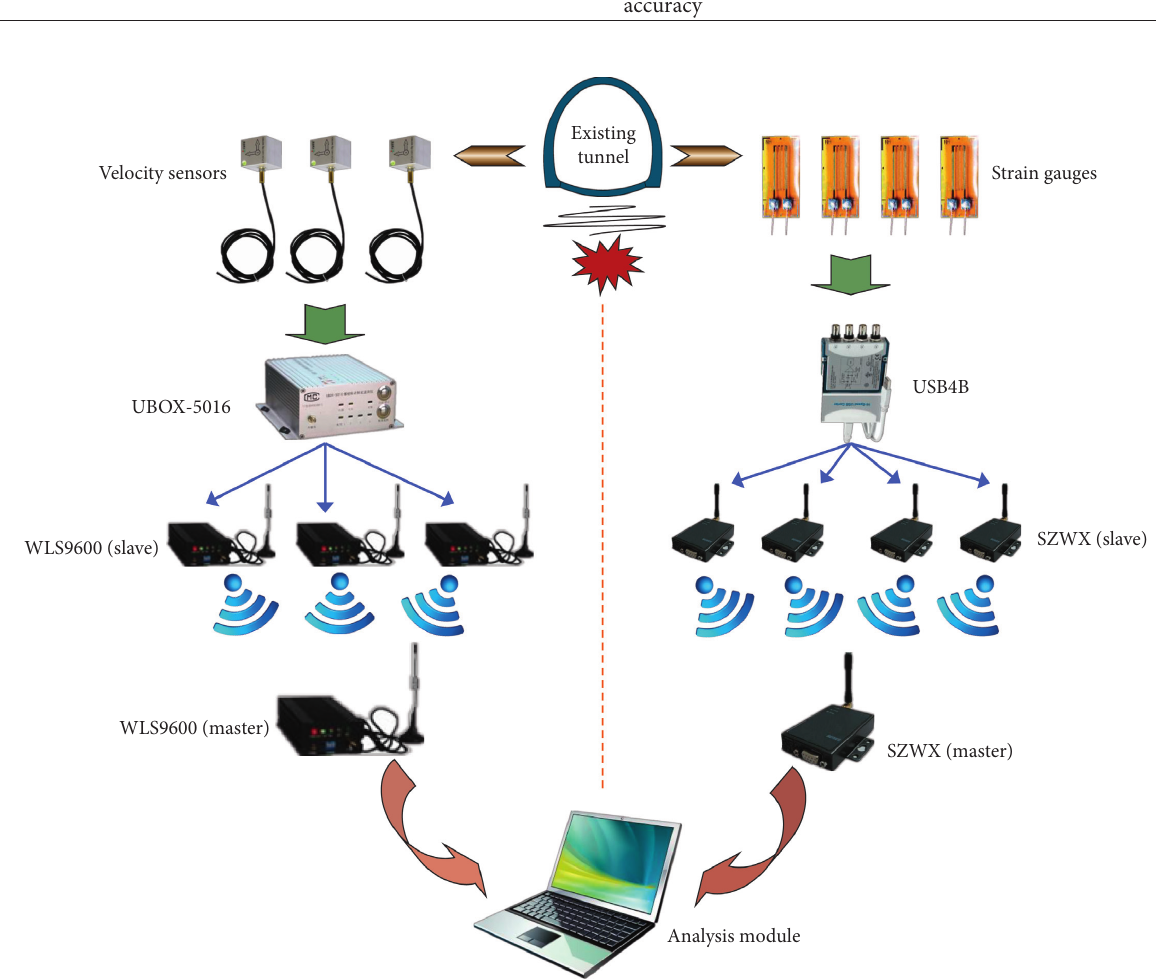
Figure 6: Wireless sensor network system [101].